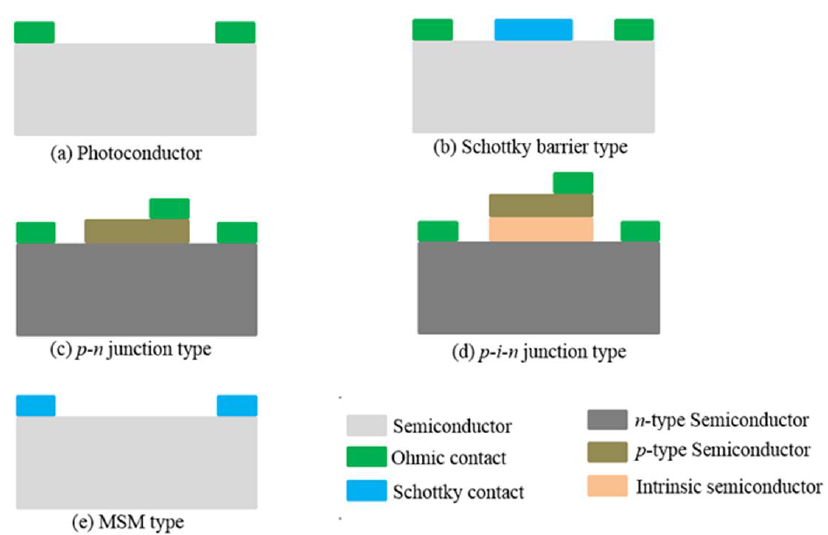
Figure 3. Schematic structure of the different types of wide bandgap semiconductor UV detector.